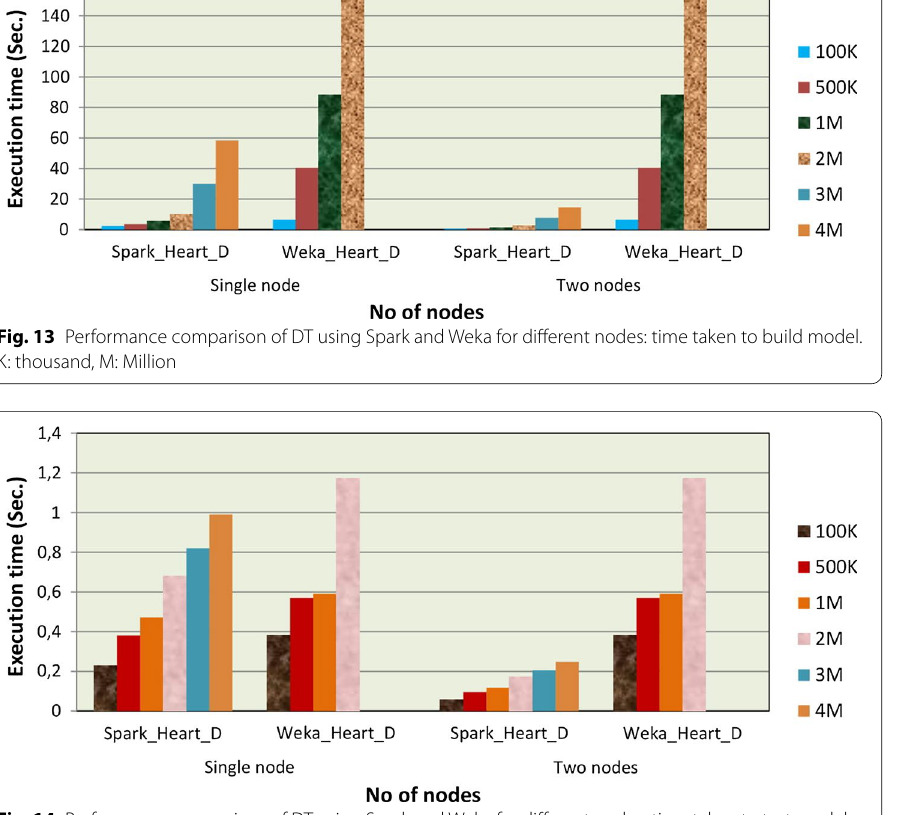
Fig. 14 Performance comparison of DT using Spark and Weka for different nodes: time taken to test model. K: thousand, M: